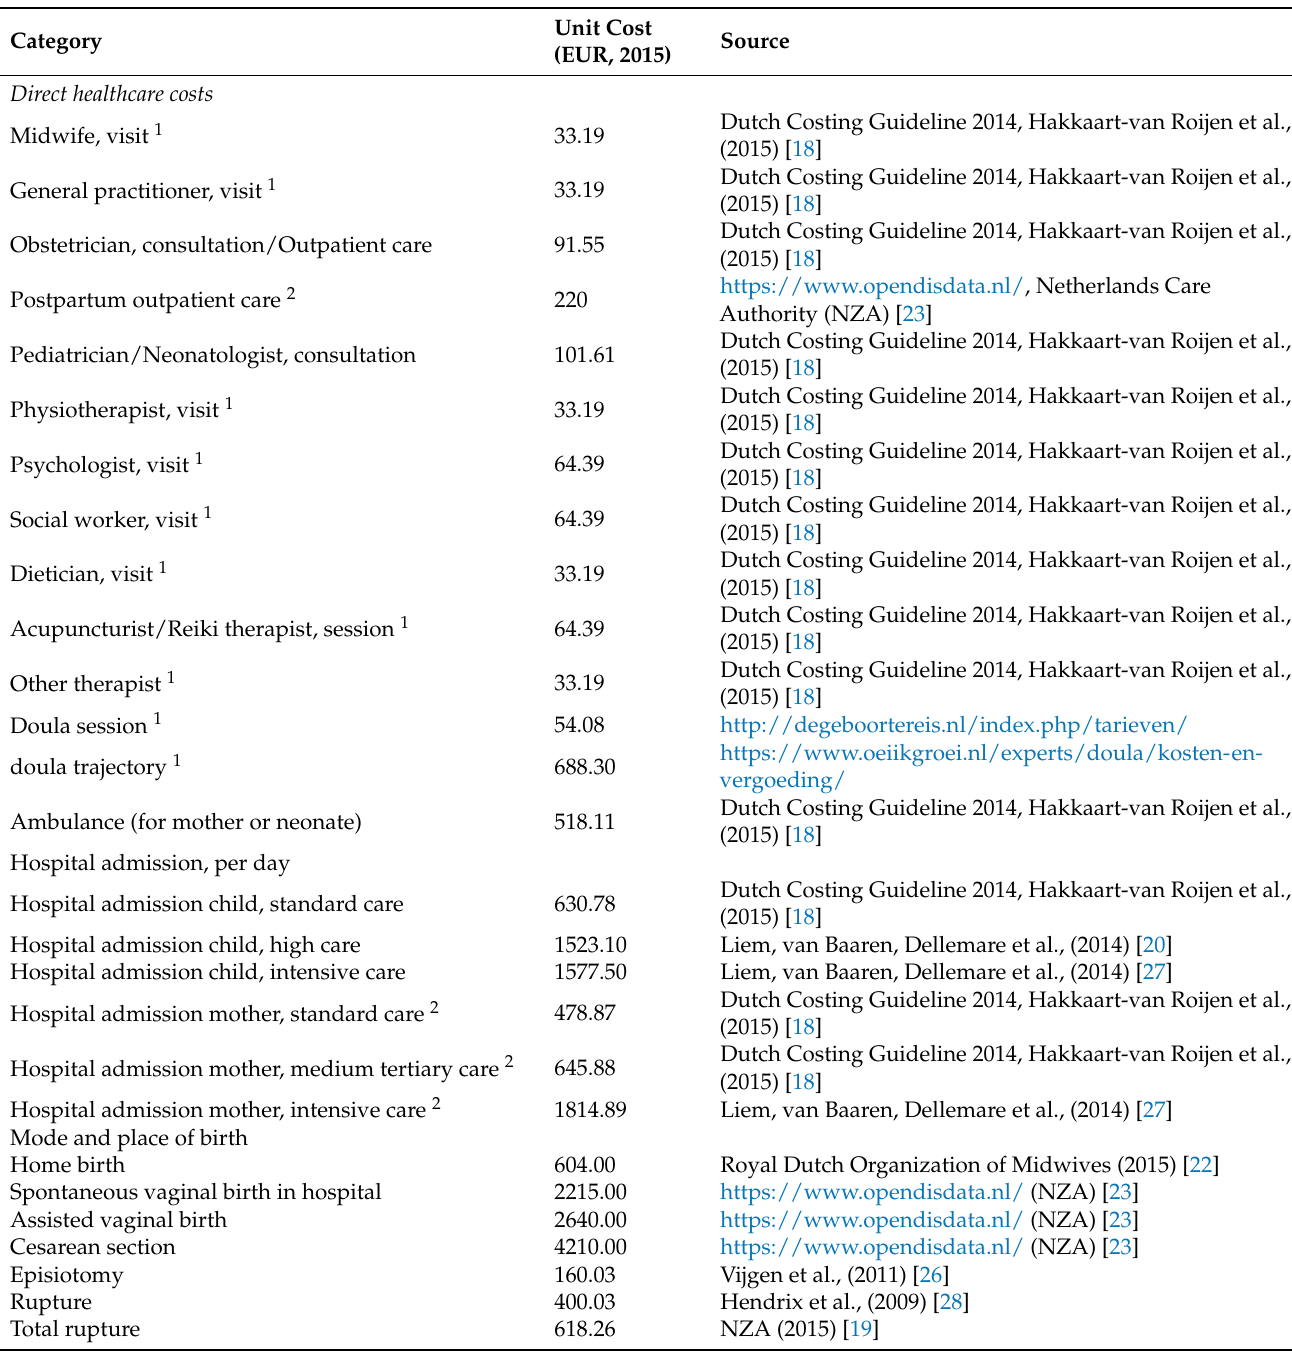
Table A1. Cost categories and unit costs (EUR, 2015) used in the economic evaluation of the IRIS